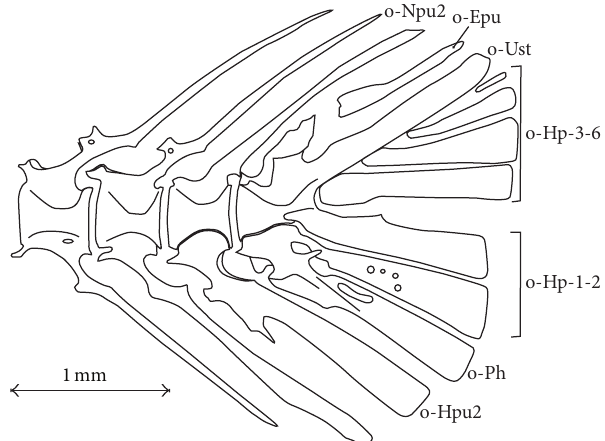
Figure 9: Caudal skeleton of Oxynoemacheilus chomanicus . Epu: epural; Hp: hypural; Hpu2: hemal process of the second preural centrum; Npu-2: neural process of the second preural centrum; Ph: parhypural; Ust: